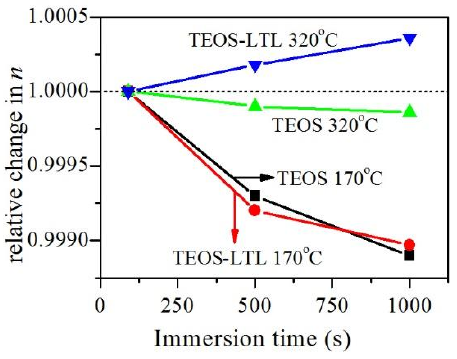
Figure 5. Relative change of refractive index (at wavelength of 800 nm) as a function of immersion time in water.